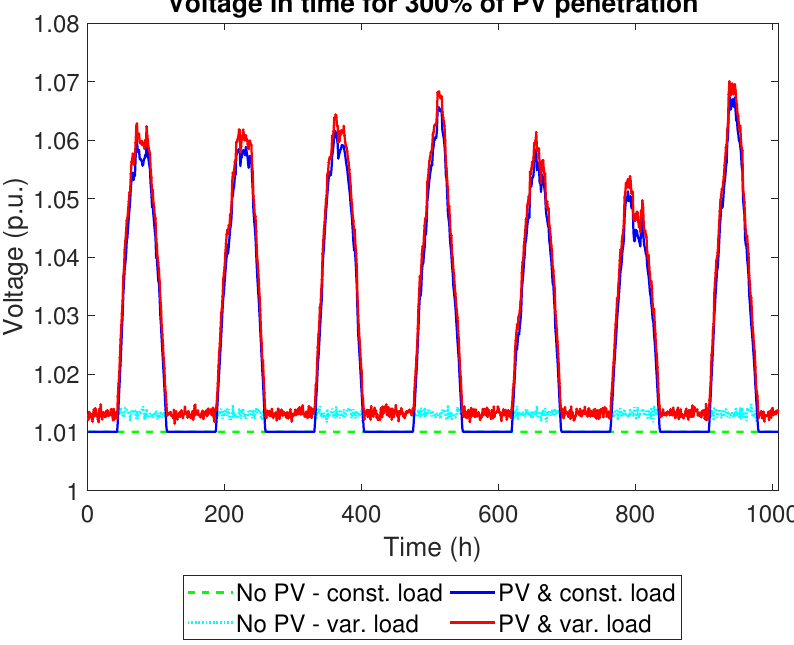
Figure 7. Averaged voltage across all buses for 300% PV